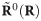
An expectation-maximization algorithm for finding noninvadable stationary states.(a) Noninvadable states by definition can only exist in the region Ω of resource space where the growth rate dNi/dt of each species i is zero or negative. Here, the blue and orange lines represent the combinations of resource abundances leading to zero growth rate for two different consumer species, so the noninvadable region is the space beneath both of the lines. Within this region, a recently discovered duality implies that the stationary state R* locally minimizes the dissimilarity d(R0, R) with respect to the fixed point R0 of the intrinsic environmental dynamics [23, 24]. (b) Metabolic byproducts move the relevant unperturbed state from R0 (gray ‘x’) to R˜0(R) (black ‘x’), which is itself a function of the current environmental conditions. Dotted contour lines represent d(R˜0(R*),R), and arrows are two trajectories of the population dynamics starting from the unperturbed environmental state with two different sets of initial consumer population sizes. See main text and Appendix for model details and parameters. (c) Pseudocode for self-consistently computing R* and R˜0(R*), which is identical to standard expectation-maximization algorithms employed for problems with latent variables in machine learning.